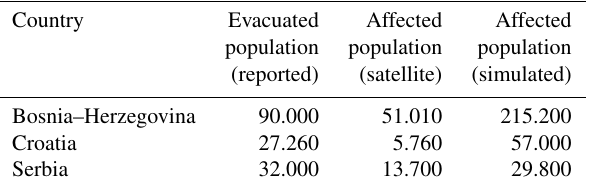
Table 4. Comparison of evacuated population (reported) and af- fected population estimated from satellite and simulations in Bosnia–Herzegovina, Croatia and Serbia (source: ICPDR and IS- RBC, 2015).